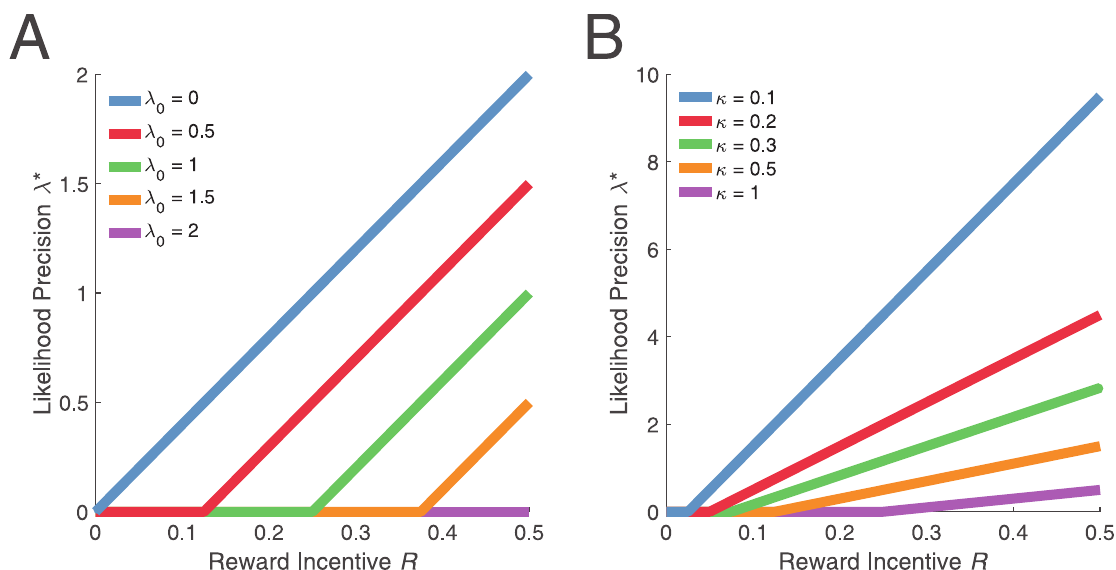
Fig 3. Relationship between reward incentive and likelihood precision under different levels of prior precision and information cost. The relationship between λ � and R is piecewise linear: When R is small, the agent is not sufficiently incentivized to attend to the task and relies only on its prior knowledge. When R is sufficiently large, the agent linearly increases λ � with R . (A) Increases in λ 0 shift the piecewise linear function to the right. (B) Increases in κ shift the function to the right and decrease the slope. For illustration, we have fixed κ = 0.5 and λ 0 = 0.5 in (A) and (B),